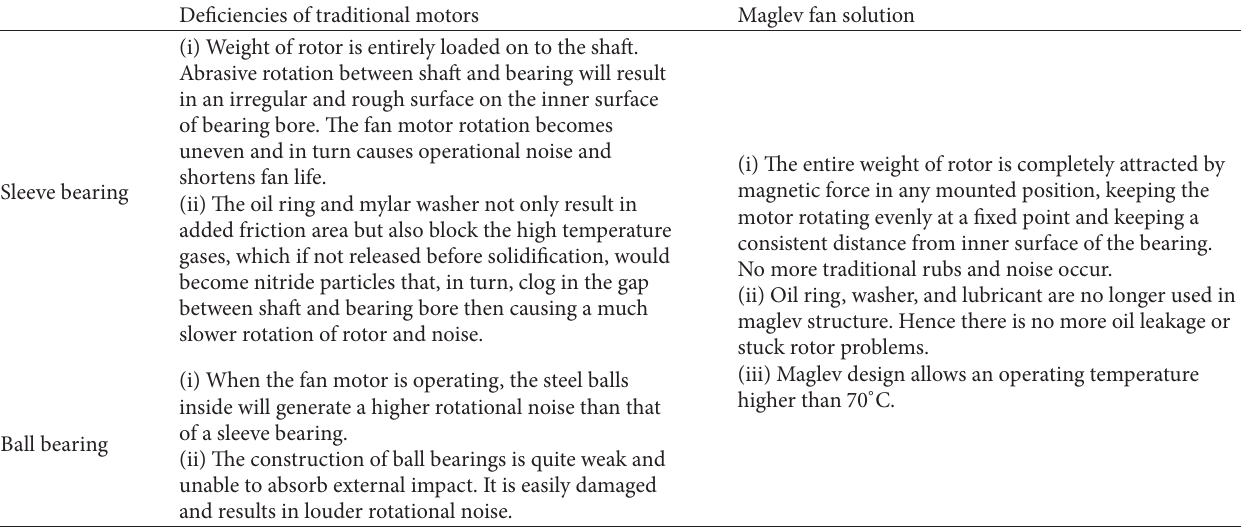
Figure 25: An axial-flow radial-flux permanent magnet motor with a stator iron strip segment. Table 1: The defects of conventional